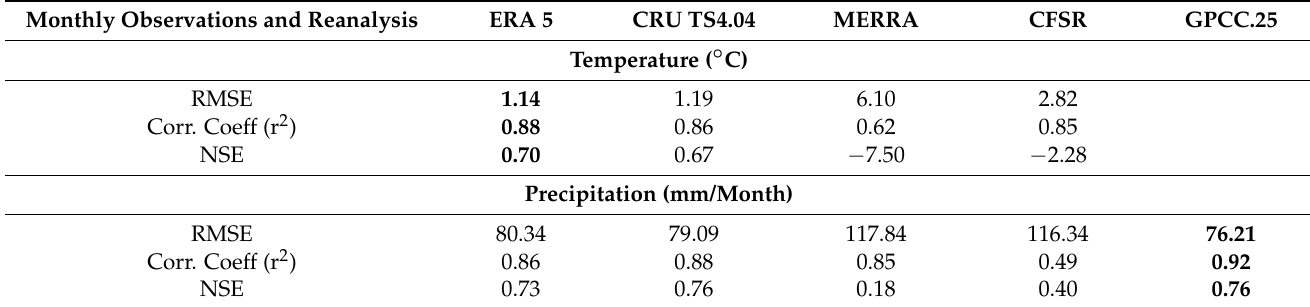
Table 2. Monthly observations and reanalysis maximum temperature and precipitation validation with UBNB area-averaged ground observations for the baseline period (1981 to